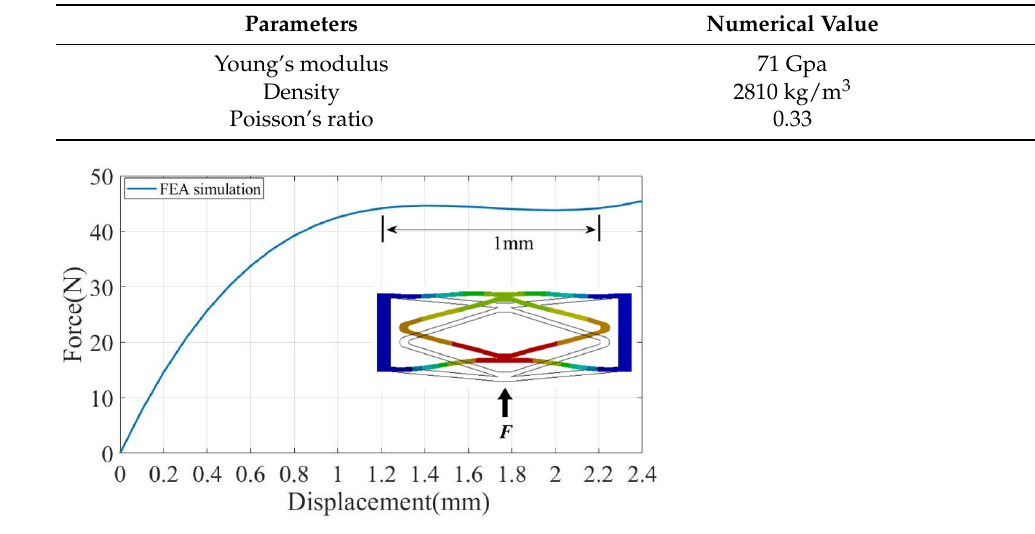
Table 2. Table of the parameters of the CFM.